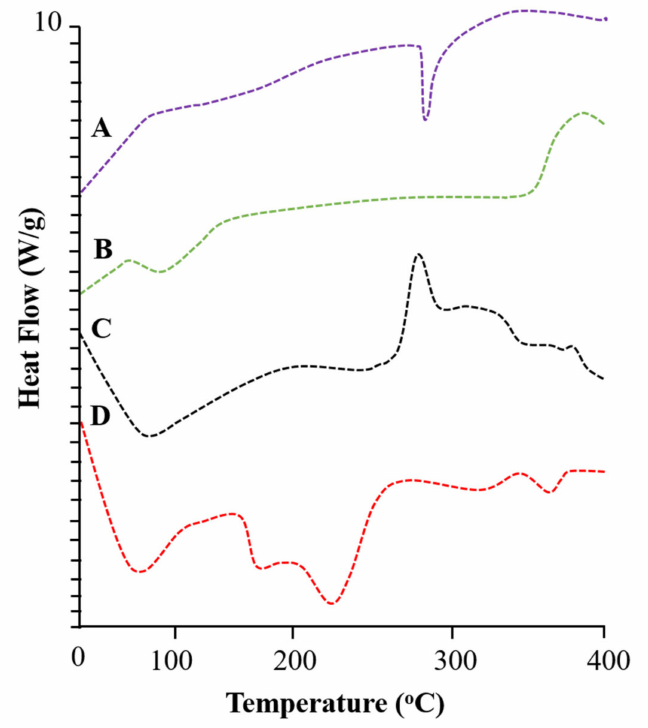
Figure 3. DSC thermograms of ( A ) acyclovir, ( B ) β -CD, ( C ) tamarind gum powder, and ( D ) the hydrogel formulation